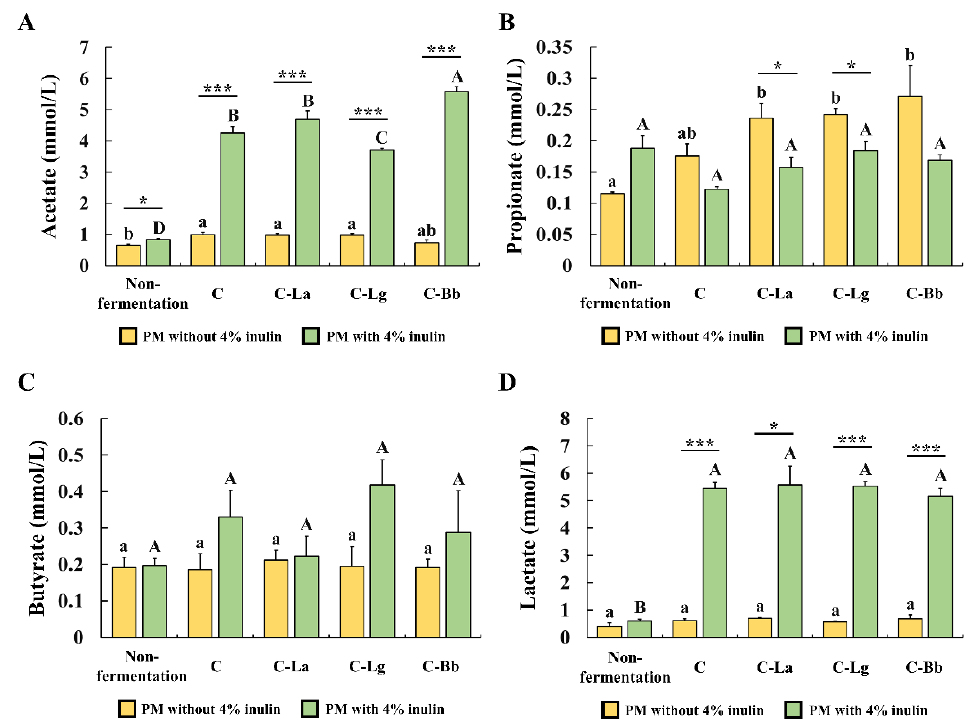
Figure 3. The concentrations of SCFAs (( A ) acetate, ( B ) propionate, and ( C ) butyrate), and ( D ) lactate in PMs and fermented PMs with or without 4% inulin as measured by gas chromatography. C = PM fermented with Streptococcus thermophilus and Lactobacillus bulgaricus ; C-La = PM fermented with S. thermophilus , L. bulgaricus , and Lactobacillus acidophilus ; C-Lg = PM fermented with S. thermophilus , L. bulgaricus , and Lactobacillus gasseri ; C-Bb = PM fermented with S. thermophilus , L. bulgaricus , and Bifidobacterium bifidum . Results are expressed as mean ± standard error ( n = 3). Means with different letters (a–b) represent significant differences among PM without inulin ( p < 0.05). Means with different letters (A–D) indicate significant differences among PM with 4% inulin ( p < 0.05). * ( p < 0.05) and *** ( p < 0.001) indicate significant differences in two PM groups with and without 4% inulin.